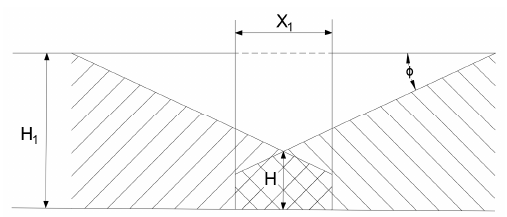
Figure 2. Self ‐ covering depth of chisel ‐ type furrow opener. Figure 2. Self-covering depth of chisel-type furrow